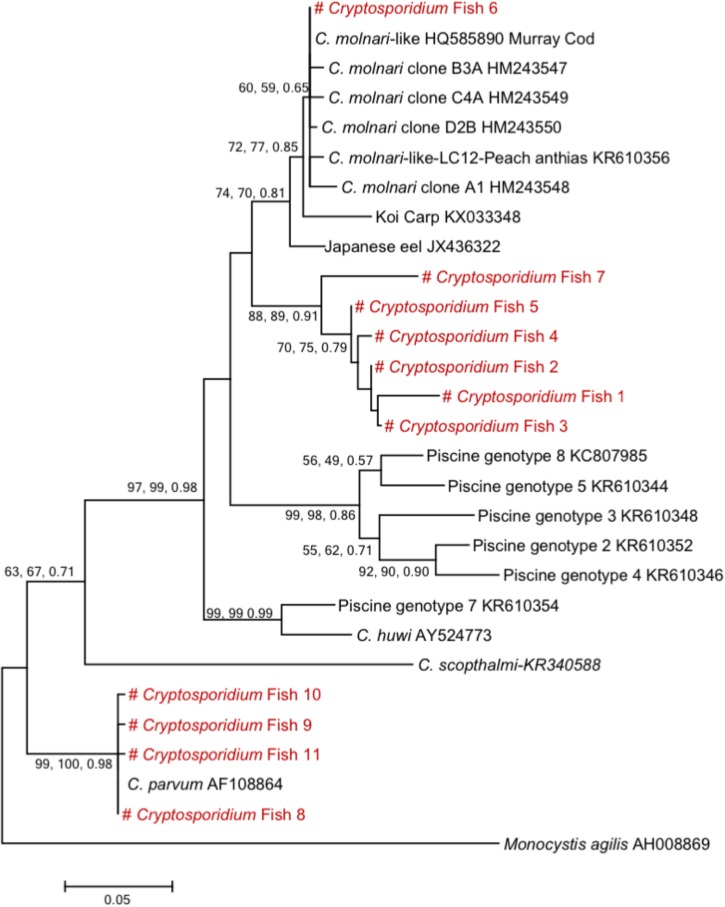
Phylogenetic tree showing the evolutional relationships of Cryptosporidium piscine isolates inferred by ML analysis of 18S rRNA gene sequences. Percentage support (>50%) from 1,000 pseudoreplicates from ML and distance analyses and posterior probabilities from Bayesian analysis are indicated at the left of the supported node. Red texts correspond to the sequences from this study.